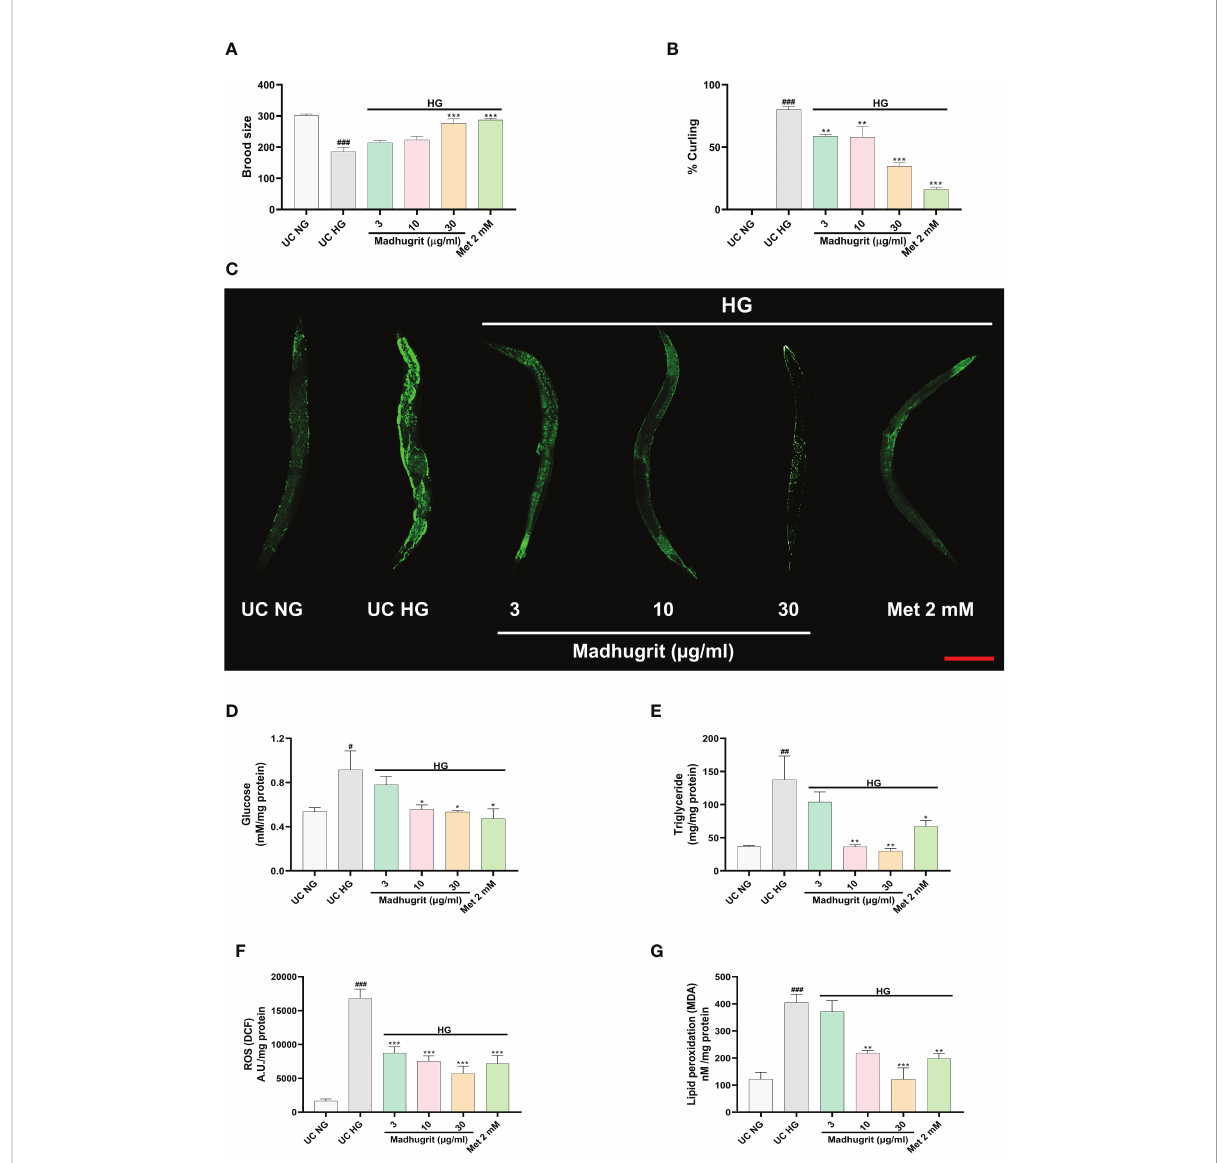
FIGURE 7 Madhugrit staved off the glucose toxicity markers in C. elegans exposed to high glucose (HG) conditions. (A) Brood size of the nematodes placed under HG was determined in presence or absence of Madhugrit (3, 10, and 30 µg/ml) or Metformin (2 mM). (B) Aberrant behavior of the worms in HG was observed in the form of curling and the number of worms in curled state were quanti fi ed in presence or absence of Madhugrit (3, 10, and 30 µg/ml) or Metformin (2 mM). (C) Lipid deposition (green) in the nematodes exposed to HG was qualitatively determined by Nile red staining in presence of different treatments. Scale bar (red)=200 µm. (D-G) Glucose, triglyceride accumulation, ROS generation and MDA levels in the nematodes were evaluated in presence or absence of Madhugrit (3, 10, and 30 µg/ml) or Metformin (2 mM). The statistical signi fi cance of the observed differences in the means compared to the UC NG group was analyzed through one-way ANOVA followed by Dunnett ’ s multiple comparison test and represented as # (p<0.05), ## (p<0.01), or ### (p<0.001). Comparison of the treatments with UC HG group was represented *, ** or *** depending on whether the calculated p value was <0.05, <0.01 or